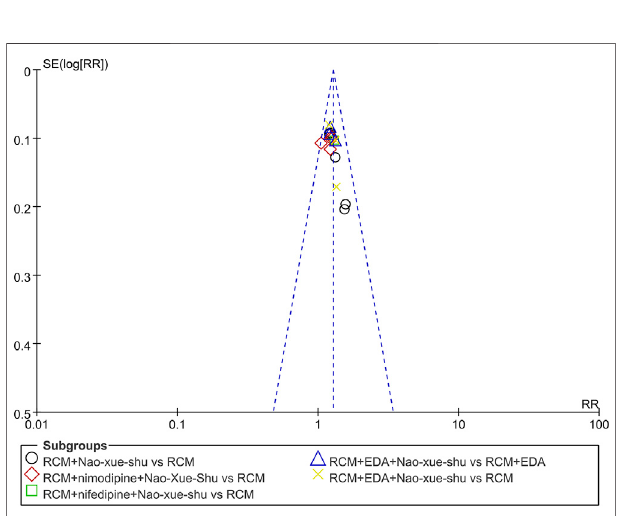
FIGURE3| Funnelplotsforthedetectionofpublicationbiasonthepost- treatment ef fi cicency.